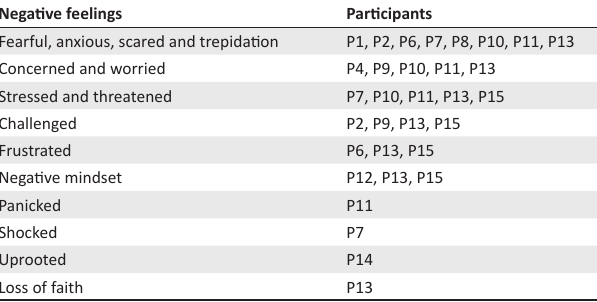
TABLE 2: Negative feelings towards the fourth industrial revolution. Negative feelings Participants